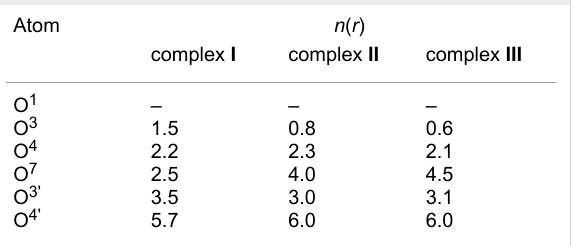
Table 1: Integration number, n ( r ), up to the first minimum from Figure 6 around the heteroatoms of fisetin in complexes I–III